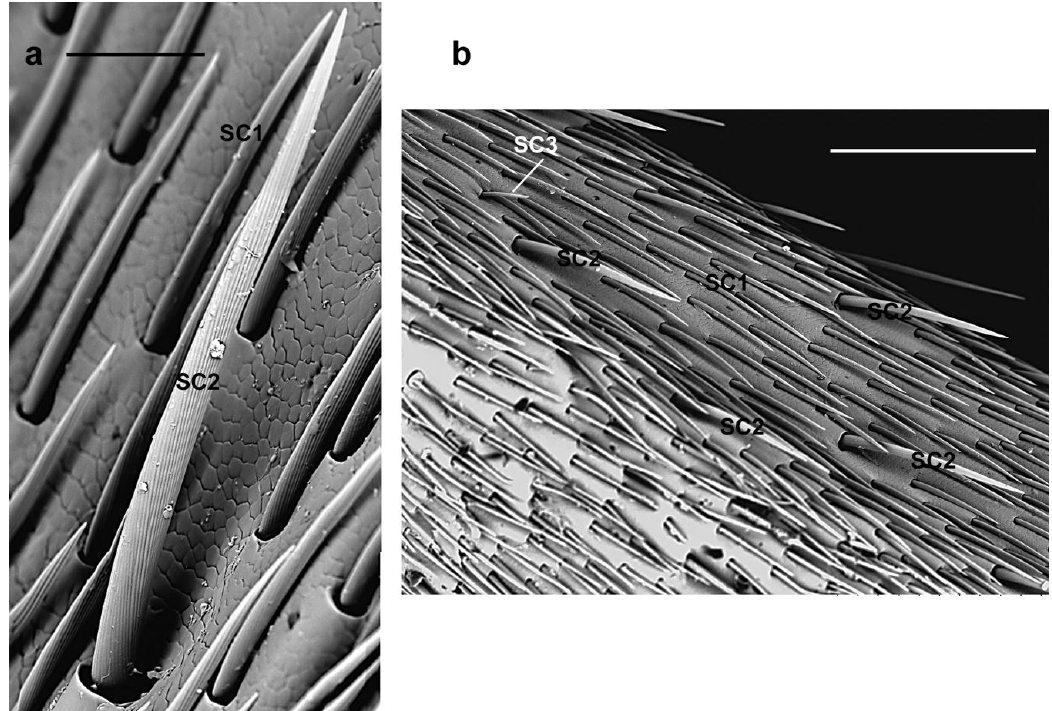
Figure 4. A. bungii , male, SEM. Sensilla chaetica SC2. ( a ) Detail of the grooved bristle with articulated socket. ( b ) Overview of the third flagellomere showing SC2 easily distinguished from SC1 by their longer shaft slightly diverging from the antennal surface. Abbreviations: SC1, sensillum chaeticum type 1; SC2, sensillum chaeticum type 2; SC3, sensillum chaeticum type 3. Scale bars: 50 µm ( a ); and 300 µm ( b ).